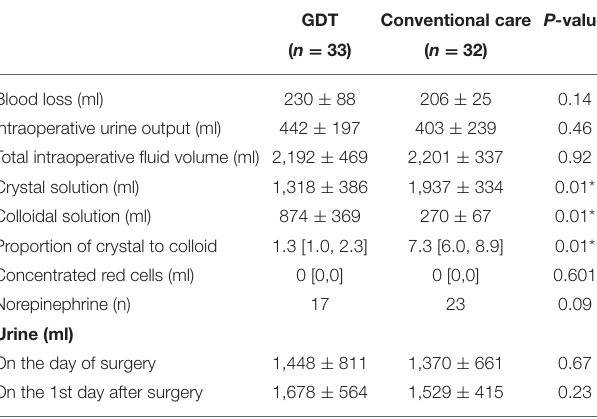
TABLE 3 | Intraoperative fluid administration and surgical-related